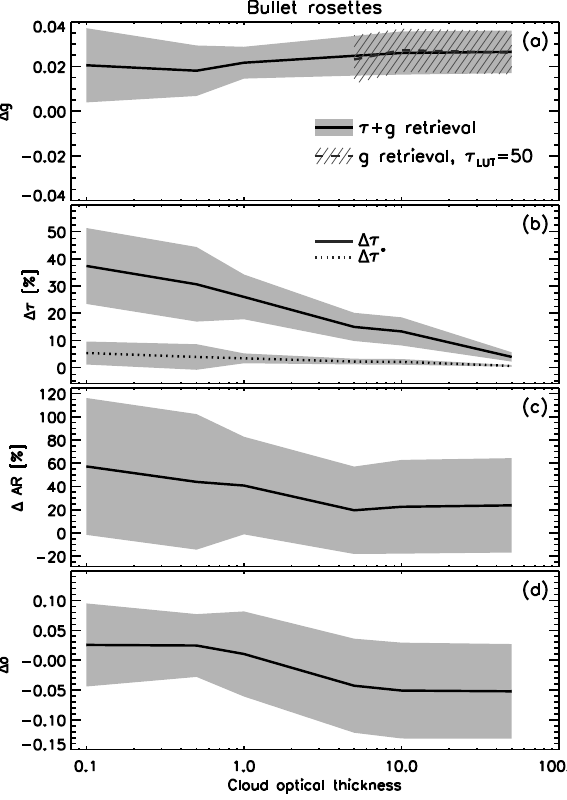
Fig. 5. Mean biases (solid lines) and standard deviations (shaded areas) of retrieved asymmetry parameters (a) , optical thickness (b) , aspect ratio (c) and roughness parameter (d) as a function of cloud optical thickness assumed in the simulated data using bullet rosettes. The dashed line and line-shaded area in (a) shows results where τ cloud = 50 is assumed in the LUT. The dotted line in (b) shows the mean bias of the scaled optical thickness (defined in